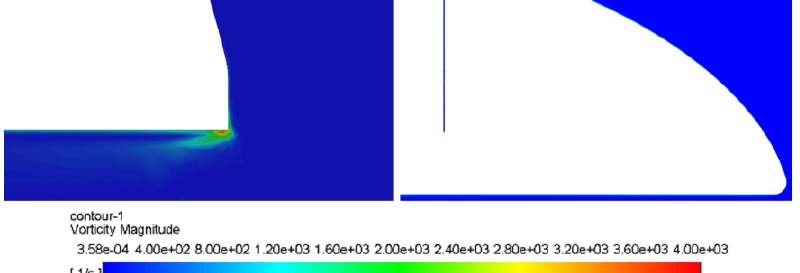
Fig. 14. Comparison of vorticity magnitude between Concept Two baseline (left), and Concept Two - Revision A